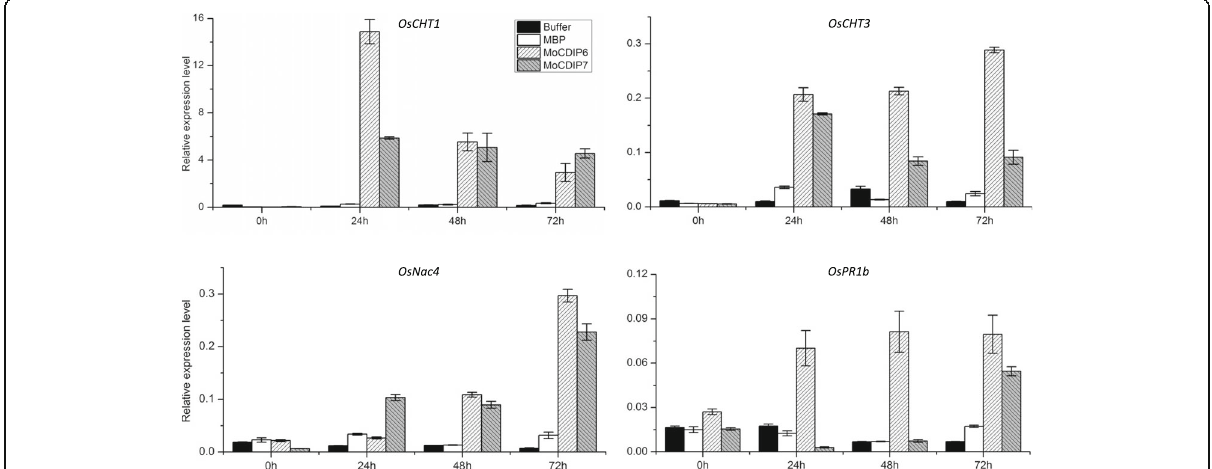
Fig. 5 Recombinant MoCDIP6 and MoCDIP7 induced PR gene expression in rice seedlings. Nipponbare rice seedlings were sprayed with recombinant MoCDIP6 and MoCDIP7 (2 μ M). Total RNA samples extracted from rice leaves at 0, 24, 48, or 72 hpi, were subjected to qRT-PCR